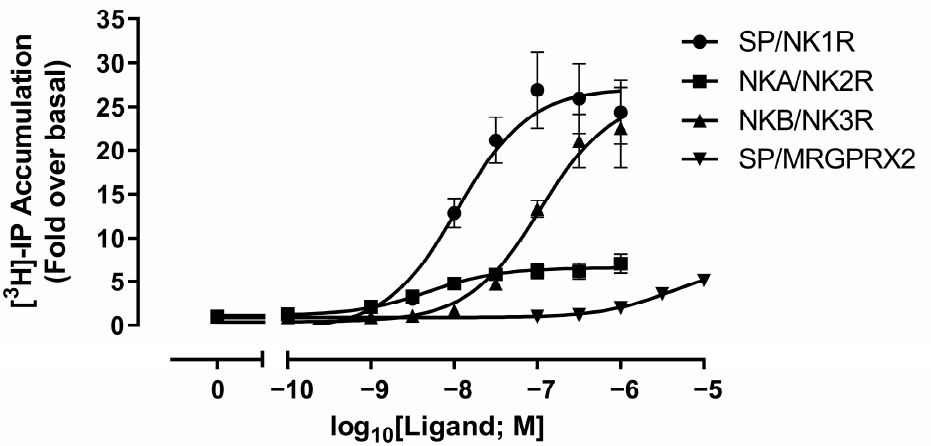
Figure 1. Dose–response analysis of neurokinin-1, -2 and -3 receptor (NK1R, NK2R or NK3R) and Mas-related G protein-coupled receptor subtype 2 (MRGPRX2) activation by cognate ligands. HEK293-T cells transfected with NK1R, NK2R, NK3R or MRGPRX2 were stimulated with a range of concentrations of Substance P (SP): NK1R and MRGPRX2, neurokinin A (NKA): NK2R, or neurokinin B (NKB): NK3R, and receptor activation was measured using an inositol phosphate (IP) accumulation assay. Data are presented as fold-over basal (signal measured in the absence of stimulating ligand; 0) and are presented as mean ± SEM ( n ≥ 3), in which each data point was performed in triplicate. Data have been fitted to three-parameter sigmoidal dose–response equations used to calculate values for potency (pEC 50 ) (Table